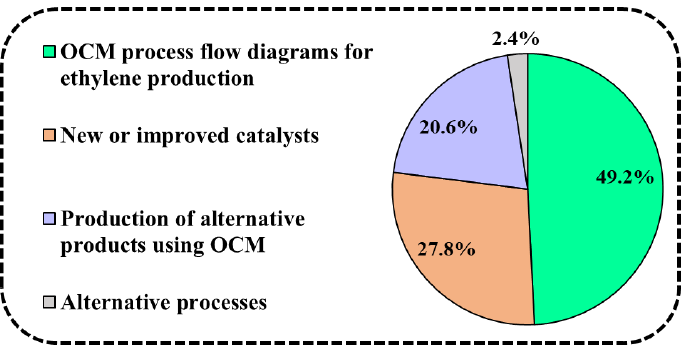
Figure 7. Distribution of topics in the extracted sample of patents, containing 121 patents filed between 2010 and